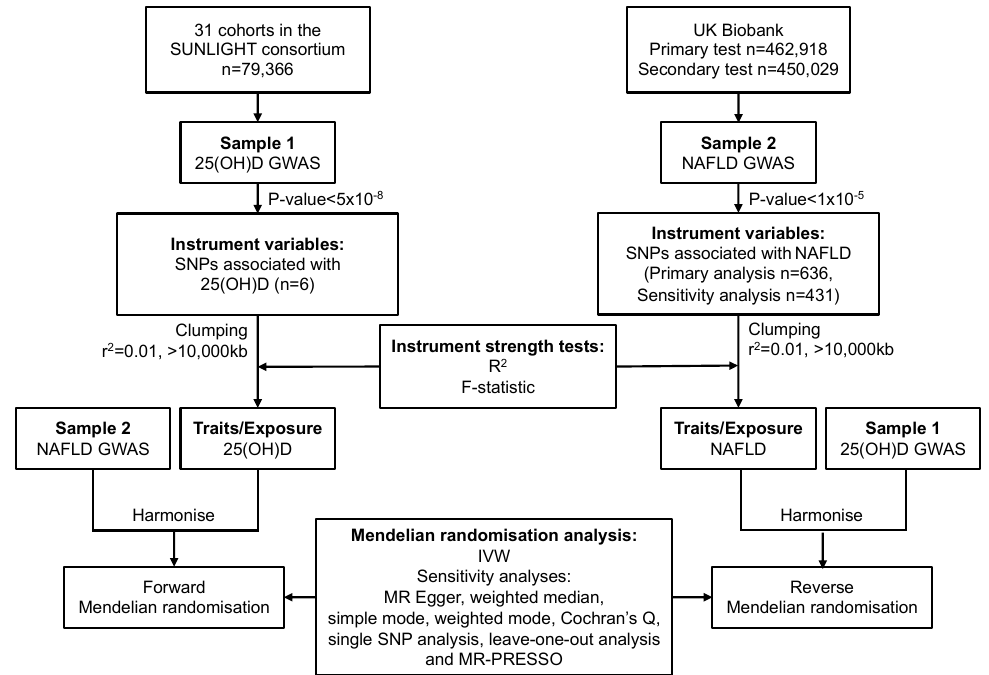
Figure 1. Overview of the two-sample MR study design used to investigate the probability of either a single or bidirectional association between serum 25(OH)D and NAFLD. 25(OH)D, 25-hydroxyvitamin D; GWAS, genome-wide association study; IVW, inverse-variance weighted; MR, Mendelian randomisation; MR-PRESSO, MR pleiotropy residual sum and outlier; NAFLD, non-alcoholic fatty liver disease; SNP, single-nucleotide polymorphism. SNPs were included if identified to be associated with NAFLD in the Speliotes’ GWAS [22] with effects in the same direction with a p -value of <1 × 10 − 5 in UKBB or were ‘discovered’ in our GWAS in UKBB with a p -value of <5 × 10 − 8